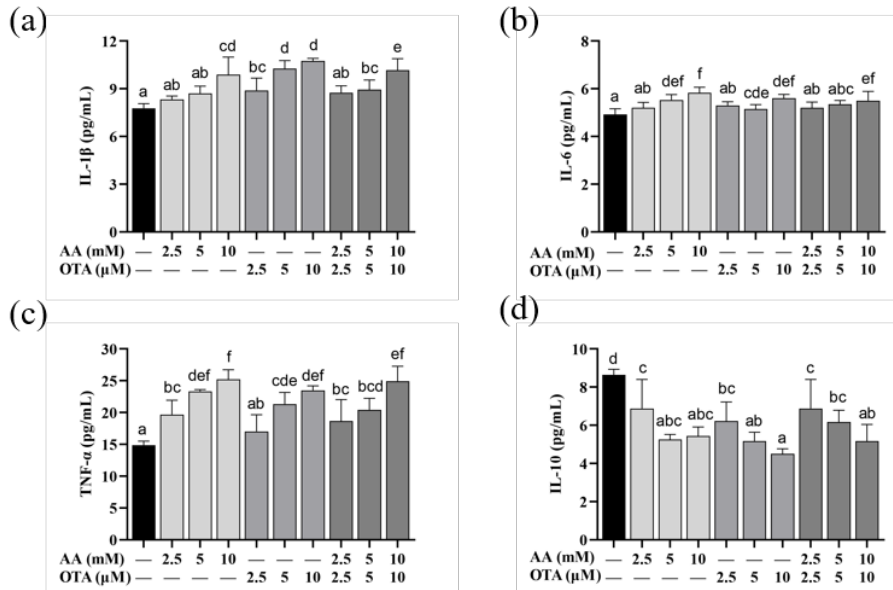
Figure 6. Effect of AA and OTA on inflammatory factors in the Caco-2 cells after 24 h. ( a ) IL-1 β content. ( b ) IL-6 content. ( c ) TNF- α content. ( d ) IL-10 content. a–f Letters indicate differences between content. ( b ) IL-6 content. ( c ) TNF- α content. ( d ) IL-10 content. a – f Letters indicate differences between groups, p < groups, p < 0.05.